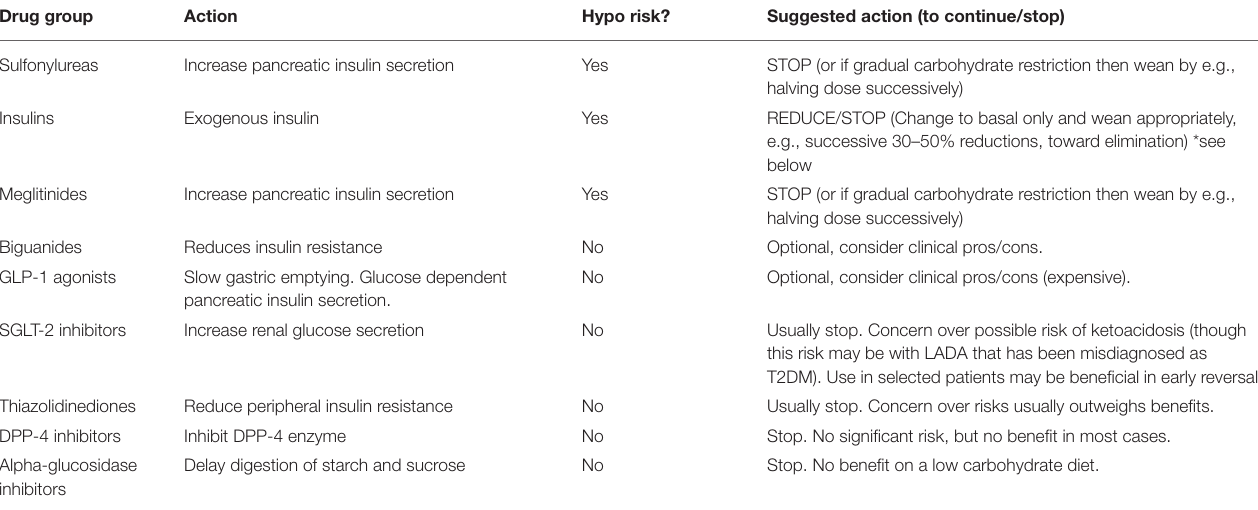
TABLE 3 | Type 2 diabetes: diabetic medications on a low carbohydrate diet– a summary and suggestions (36). Drug